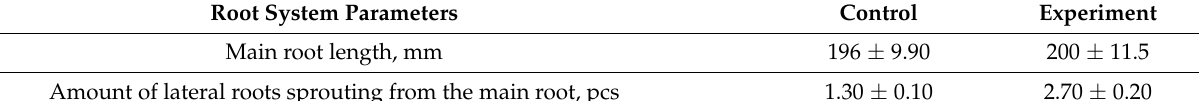
Figure 9. The root system of S. tau-saghyz seedlings (( 1 ): control; ( 2 ): experiment). Table 2. Influence of 20% vermicompost on S. tau-saghyz root system development (on 172nd